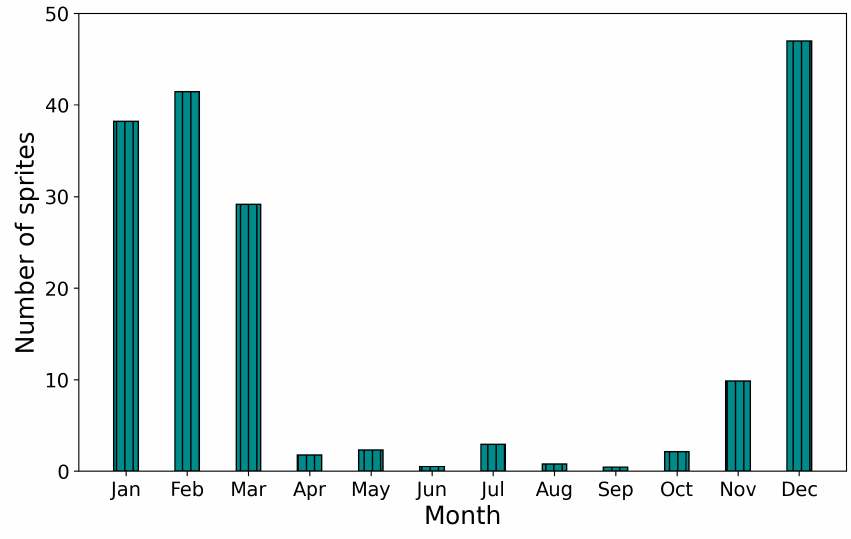
Figure 5. Estimated monthly distribution of sprites in case A (see caption of Table 1 for an explanation of the three different cases).